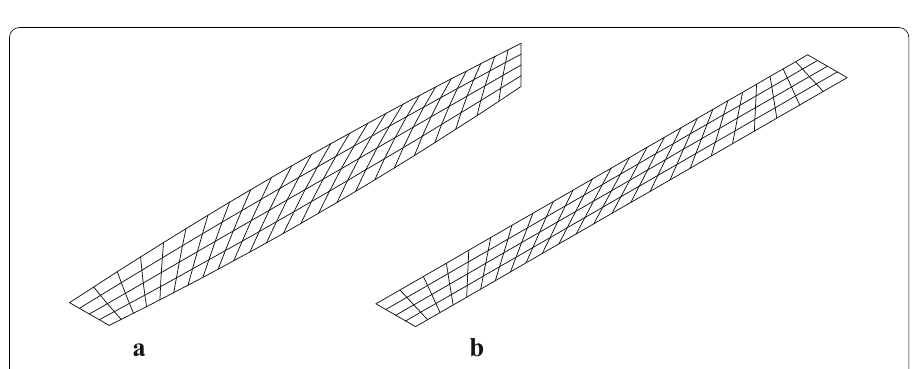
Fig. 17 Twisted beam: P − u zA and P − u yA for the regular 4 × 24 mesh